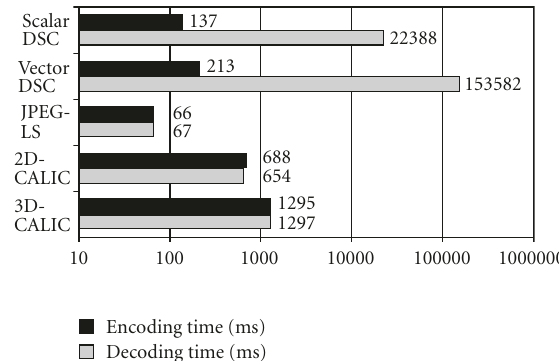
Figure 4: Computational complexities of DSC and conventional codecs. Both the per-band complexities of the encoder and the de- coder are reported.